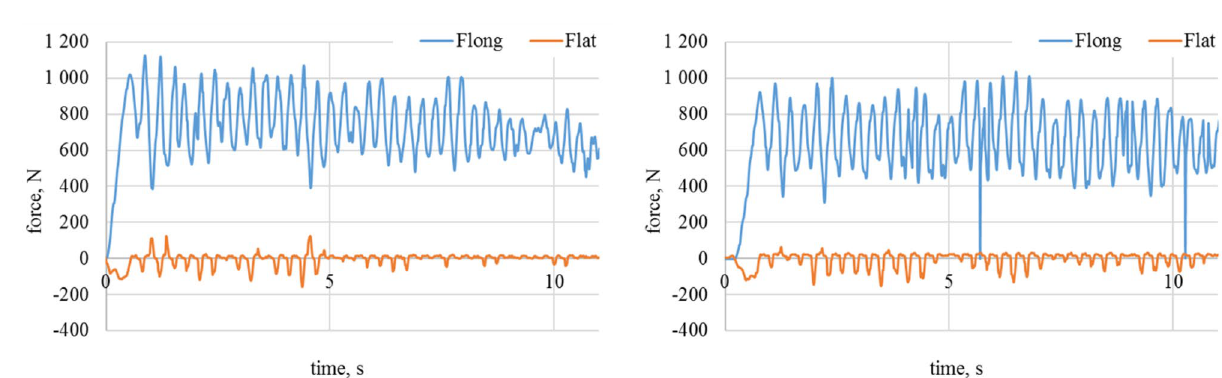
Figure 10. Longitudinal and lateral forces related to the wheel geometry for α w = 90. On the left waveform raw data for the loose snow; on the right waveform raw data for compacted